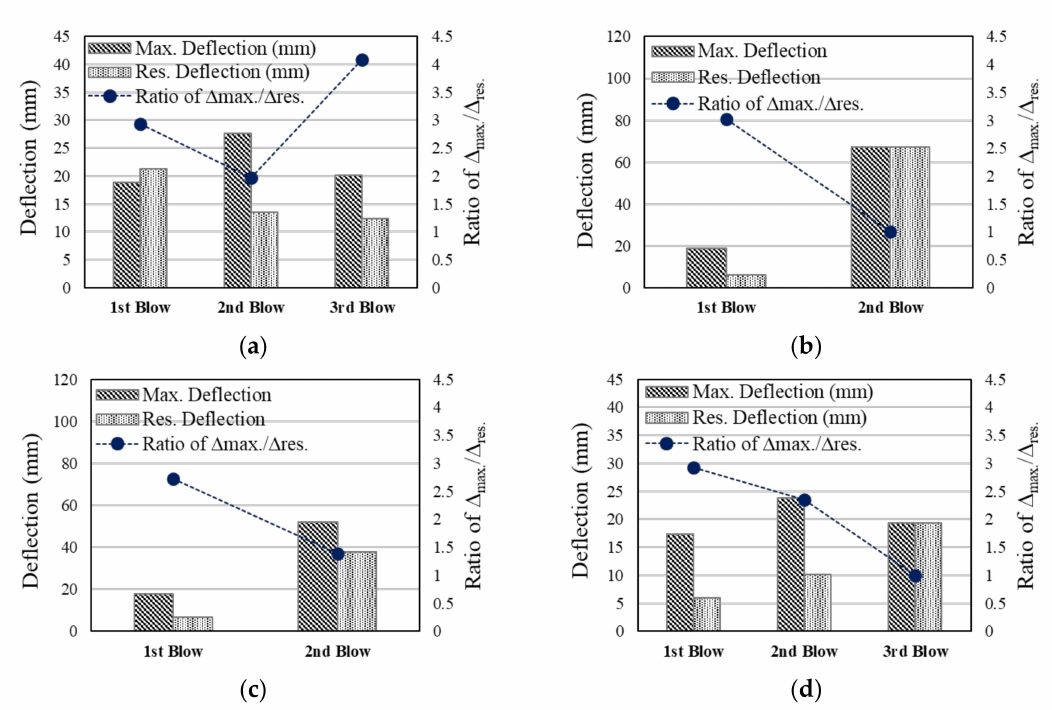
Figure 5. Blow-deflection measurement at each blow under impact loading: ( a ) NSC-NF series;